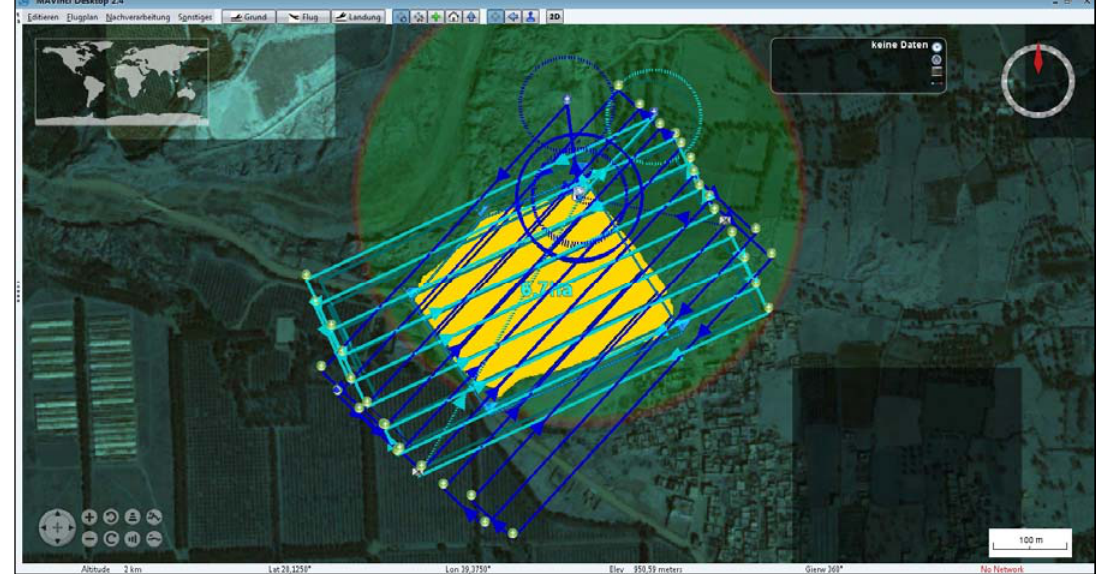
Figure 7. Flight plan for a medium sized study site (HOU, 85 m flying height).